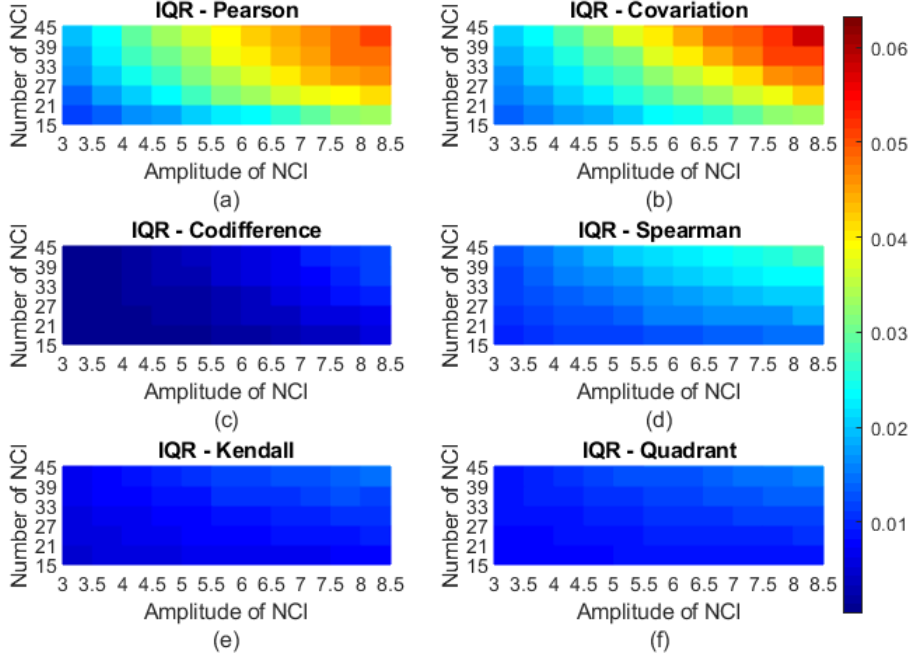
Figure 11. IQRs—calculated for part C of auto-dependence maps from Monte Carlo simulation based on the following measure of dependence: ( a ) Pearson autocorrelation, ( b ) autocovariation , ( c ) autocodifference, ( d ) Spearman autocorrelations, ( e ) Kendall autocorrelation and ( f ) Quadrant